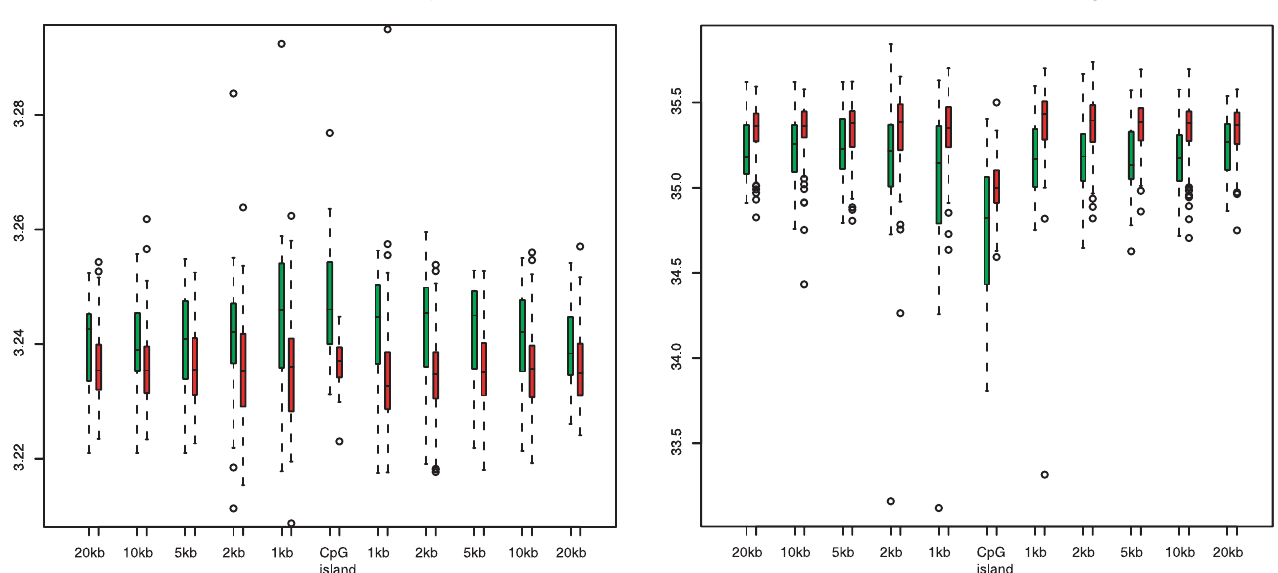
Figure 1. Predicted DNA Structure Differs in the Neighborhood of Methylated CpG Islands Compared with Their Unmethylated Counterparts The diagram on the left shows boxplots of the predicted DNA rise distribution over the CpG island and the ten sequence windows from (cid:1) 20 kb to 20 kb surrounding the CpG island (averaged over all 132 CpG islands in the Chromosome 21 dataset). Green bars (left) correspond to methylated CpG islands, red bars (right) to unmethylated CpG islands. The diagram on the right shows similar information for the predicted DNA twist. DOI: